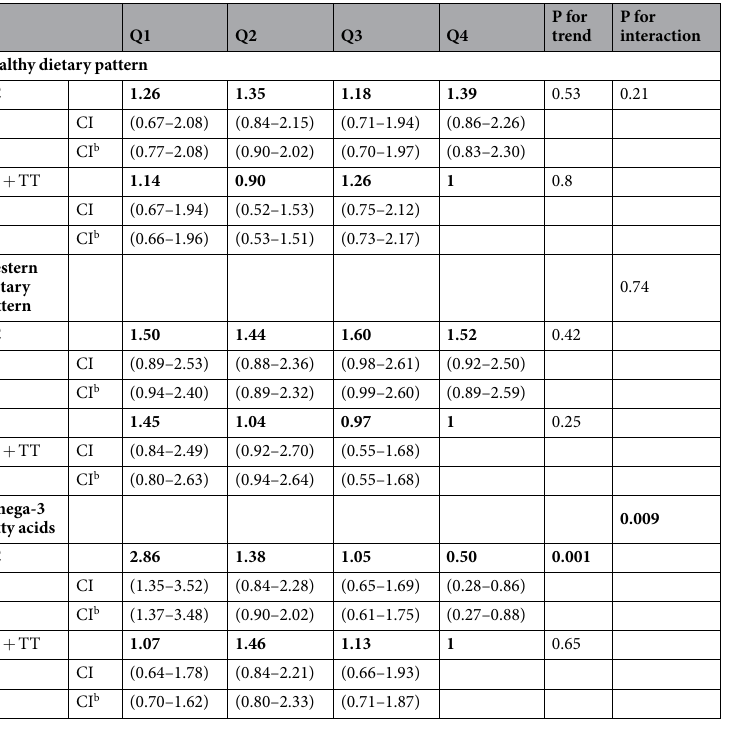
Table 3. Adjusted ORs (95% CI) for MetS according to quartiles of dietary pattern scores a . OR: Odds Ratio, Q: Quartiles of dietary pattern scores or omega 3 fatty acid (Q1 < 0.33, Q2:0.33–0.45, Q3:0.45–0.58 and Q4 > 0.58% of energy). a ORs (95% CI) were calculated by using conditional logistic regression model, adjusted for baseline BMI and the interaction term (SNP × dietary pattern scores). Participants were classified (8 groups) according to quartiles of dietary pattern scores and rs13266634 genotypes. The highest quartile of dietary pattern scores and homozygote genotype of major allele were used as the reference group. b CI after Bootstrap